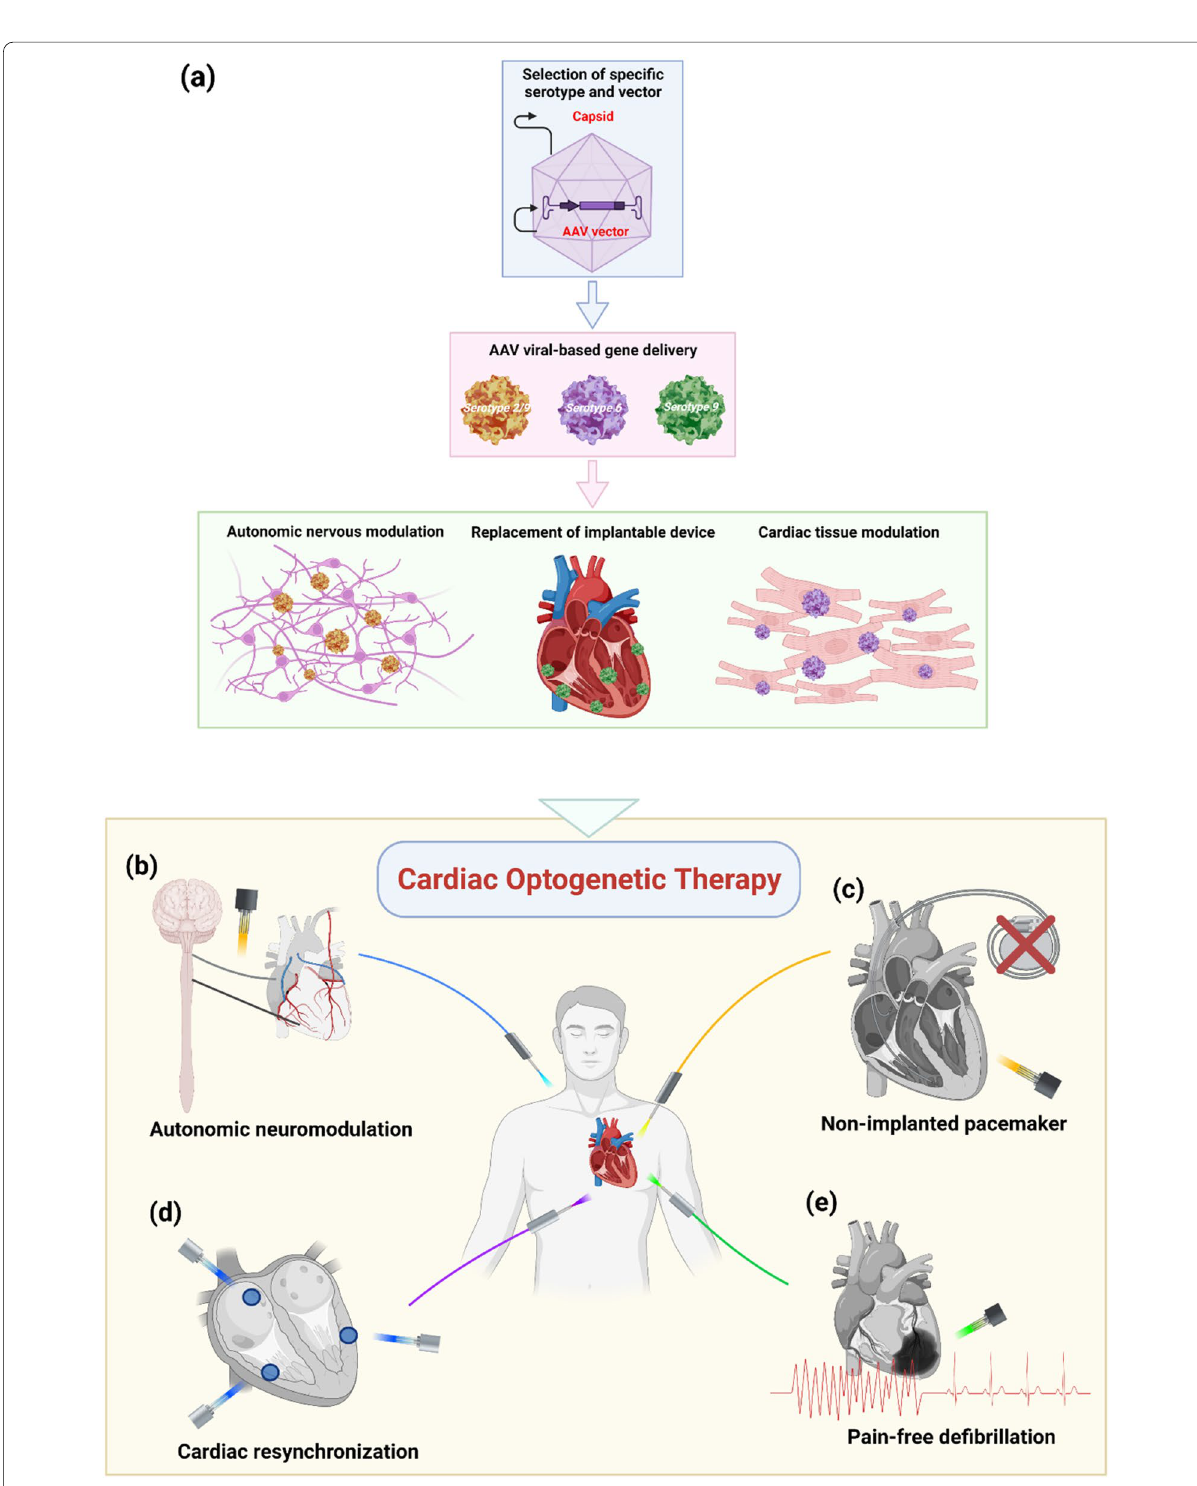
Fig. 7 Proof of concept in optogenetic treatment in heart disease. Figure created with